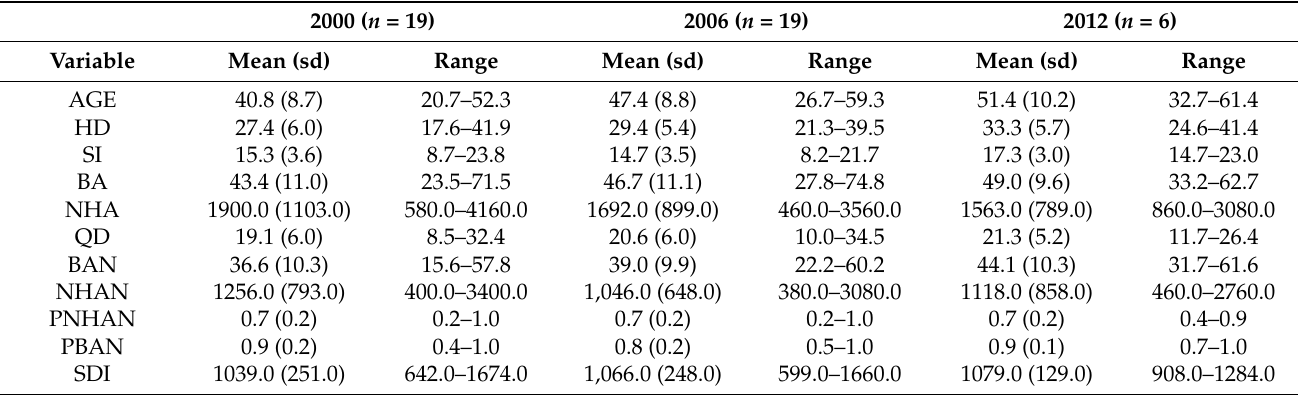
Table 1. Stand parameters in the permanent plots in second-growth RORACO forests in southern Chile established in 2000 and remeasured in 2006 and